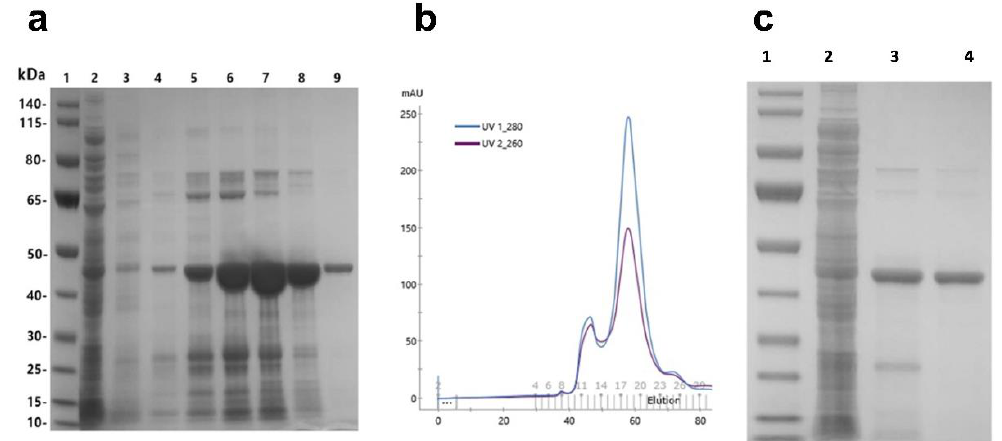
Appendix Figure A1. Purification procedure of recombinant E01-GS-inhibitory prodomain of ADAM17 (TPD). ( a ) following protein production in E. coli BL21(DE3), bacteria were lysed by sonication. The